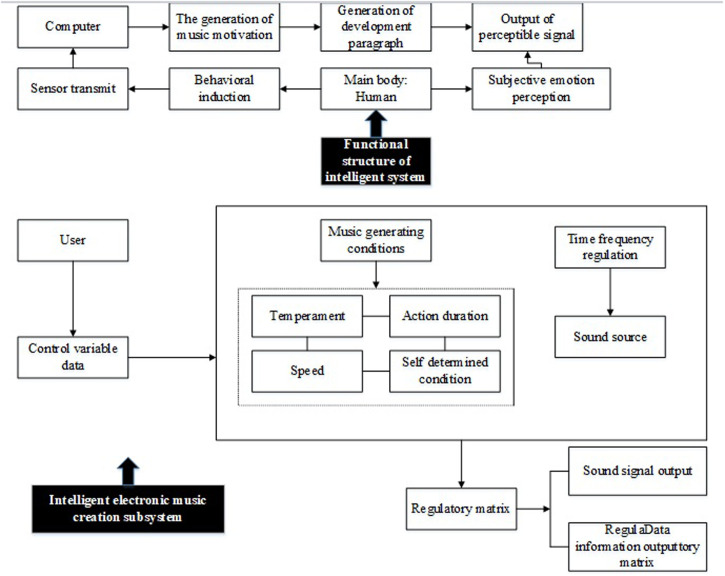
Function realization of all-media intelligent electronic music system.